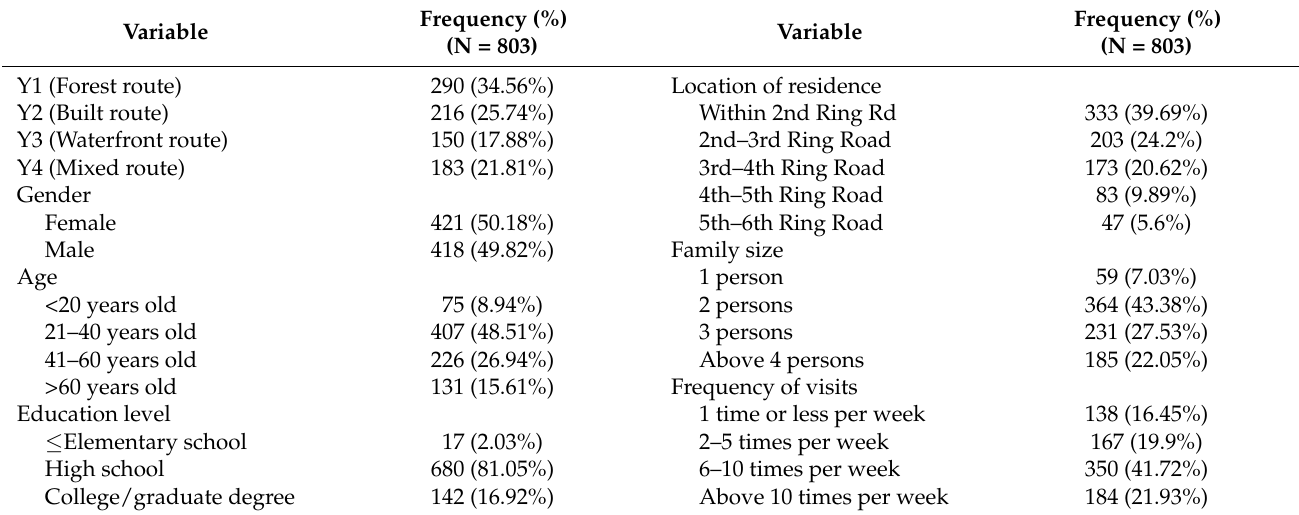
Table 2. Descriptive statistics of samples